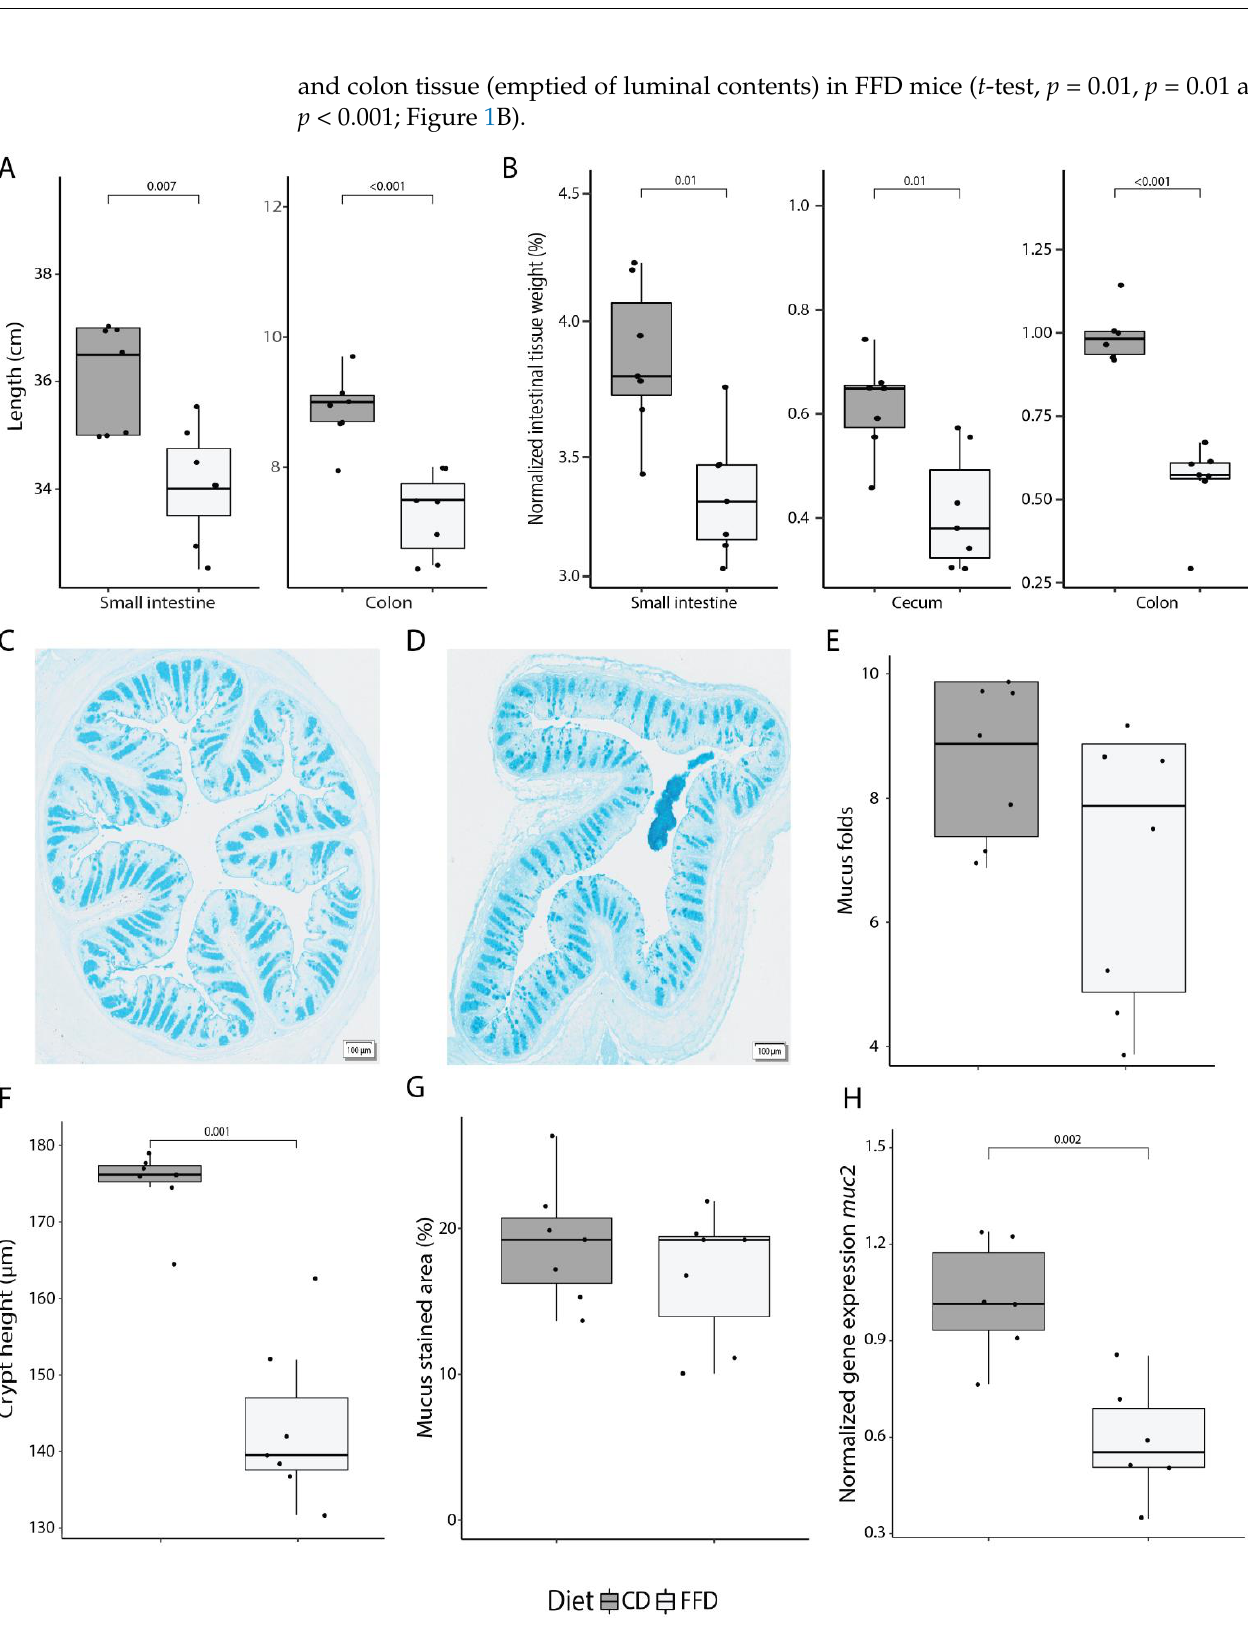
Figure 1. Dietary fiber deficiency affects intestinal anatomy and colonic mucus production. ( A ) Length of the small and large intestine is significantly decreased after 7 days of fiber deficiency (ANOVA, p < 0.001). ( B ) Fiber deficiency decreases intestinal tissue weight (ANOVA, p < 0.001). Values were normalized to the total body weight of the mouse. ( C ) A representative colon cross-section of a control mouse, and ( D ) fiber-deficient mouse displaying a loss in tissue structure at 40 × magnification. ( E ) Using a cross-section of the colon, intestinal longitudinal folds were counted. A decreasing trend was observed in fiber-deficient mice. ( F ) Crypt height, as measured from the bot- tom to the top of the crypt, significantly decreased with fiber deficiency ( t -test, p < 0.001). ( G )